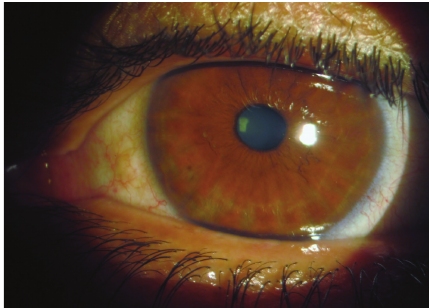
Figure 3: Slit-lamp photo; no louse and nit (posttreatment, 1st